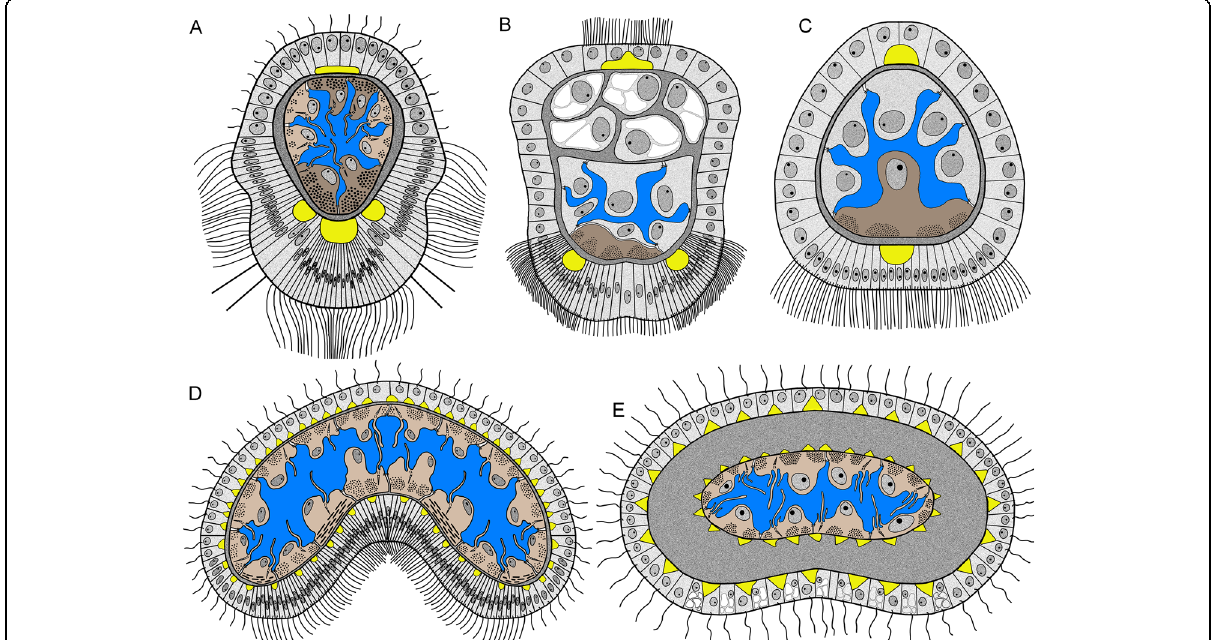
Fig. 13 Schemes of transverse section of tentacles of different types. Blood vessel is not shown. Oral side is to the down; aboral side is at the top. A , B highly specialized tentacles; C – less specialized tentacle; D , E non-specialized tentacles. A Generalized tentacle of lophophorates (based on 32,48,51). B Generalized tentacle of Serpullidae and Sabellidae (based on 85). C Generalized tentacle of Fabriciidae (based on 85) and serpullid Pomatoceros triqueter (based on 73). D Tentacle of Owenia borealis (this study). E Tentacle of holothuria Holothuria forskali (based on 88). Color code: yellow – nerve elemants; blue – coelomic cavity; light brown – myoepithelial cells; dark brown – mucle cells and myoepithelial cells with numerous myofilaments; dark grey – extracellulart matrix; light grey – epithelial